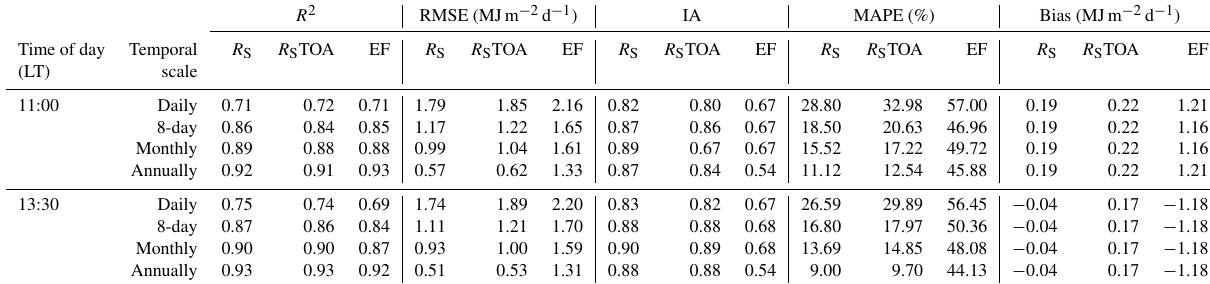
Table 3. Error statistics of ET d_pred at four different temporal scales from three ET i upscaling methods.